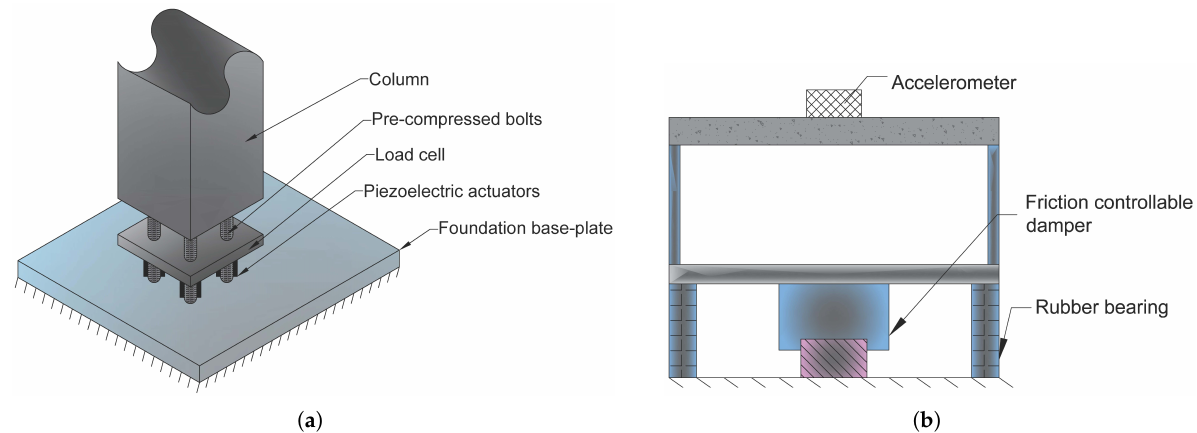
Figure 22. ( a ) Actuator configuration at the bottom of the column [84]; ( b ) structure model of the semi-active base isolation system [87].